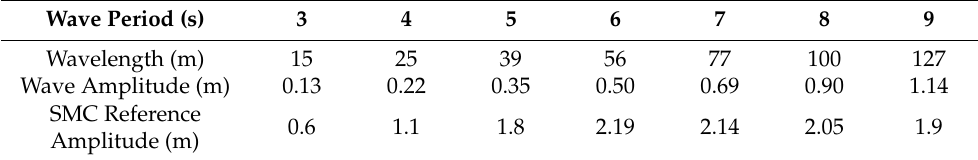
Table 2. Wave characteristics and control